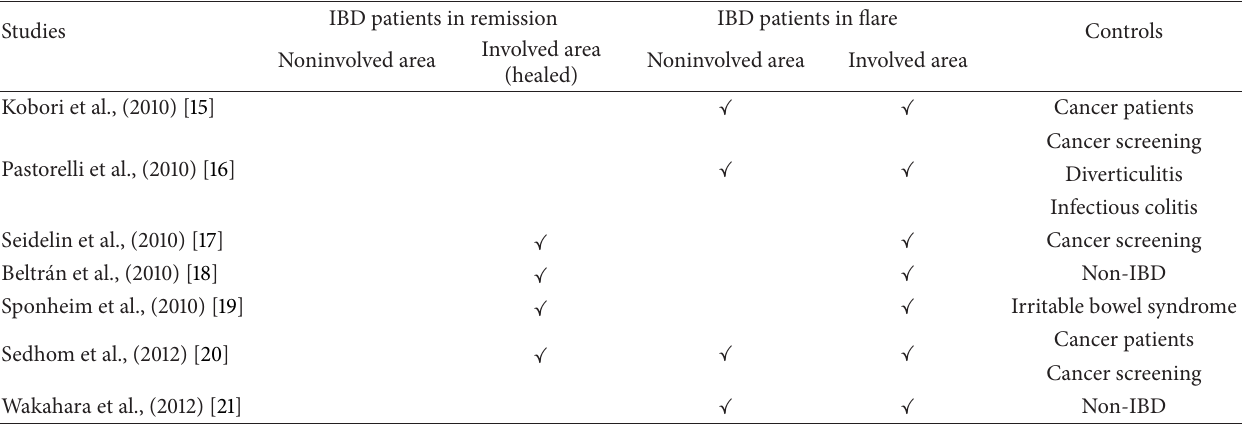
Table1:StudiesevaluatingIL-33inintestinalsamplesfrominflammatoryboweldiseasepatientsarelistedchronologicallywithdataregarding the sample collection site and the control